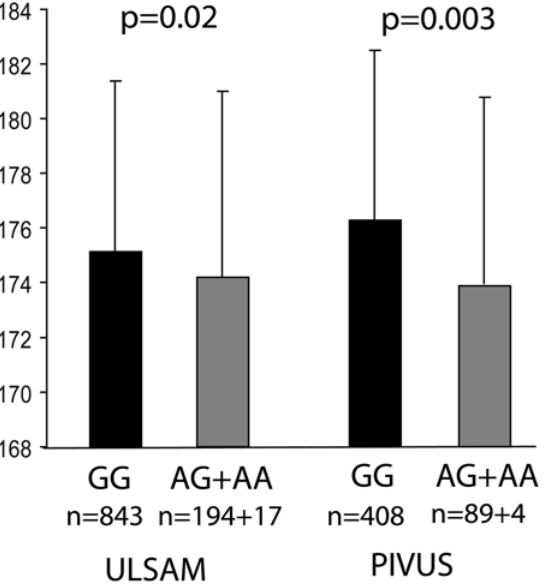
Figure 1. Analysis of body height according to genotype of the SNP rs2179922 in the ULSAM and PIVUS cohorts. The number of observations (n) is shown below each genotype group and the error bars indicate the standard deviation in cm in each group. Mean body height in the ULSAM cohort was 175.1 6 6.0 cm for GG genotype group and 174.2 6 6.8 cm for the AG + AA group. Mean body height in the PIVUS cohort was 172.2 6 6.3 cm for GG genotype group and 173.9 6 6.8 cm for the AG + AA group.